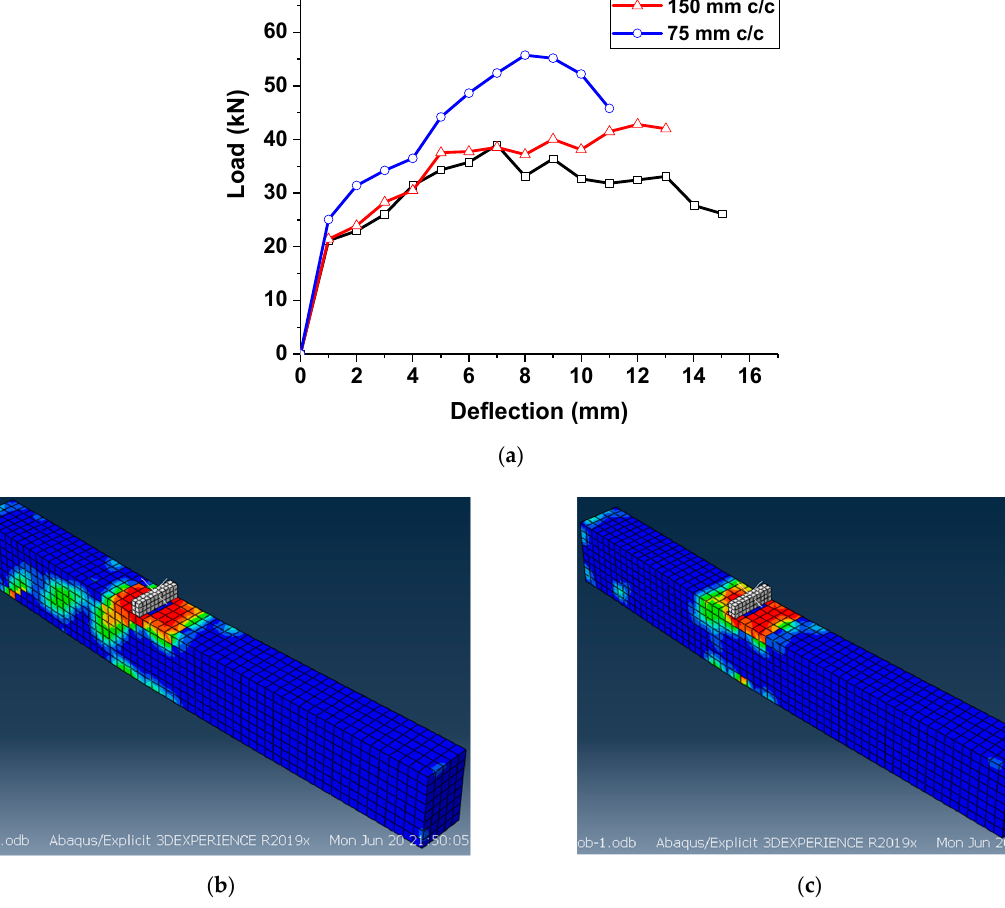
Figure 12. Parametric studies on hybrid ECC beams: ( a ) effect of transverse reinforcement spacing on shear span, ( b ) shear failure at 150 mm c/c stirrup spacing on shear span and ( c ) flexure failure at 75 mm c/c stirrup spacing on shear span.